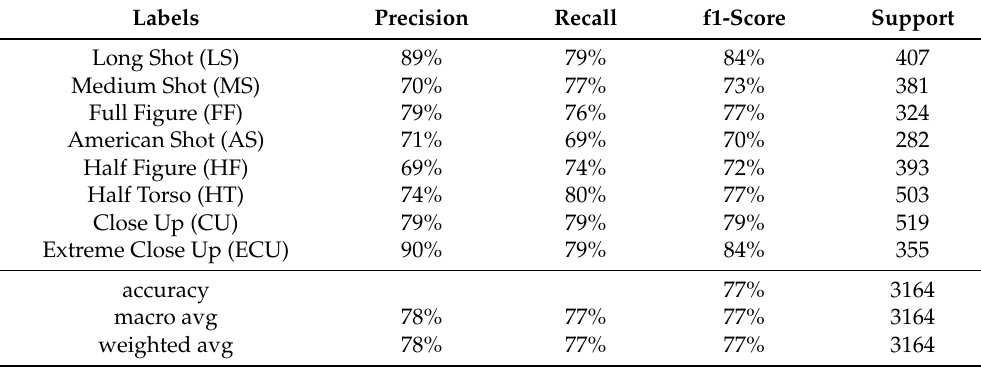
Table 6. Precision recall and f1-score of the MLP as fourth